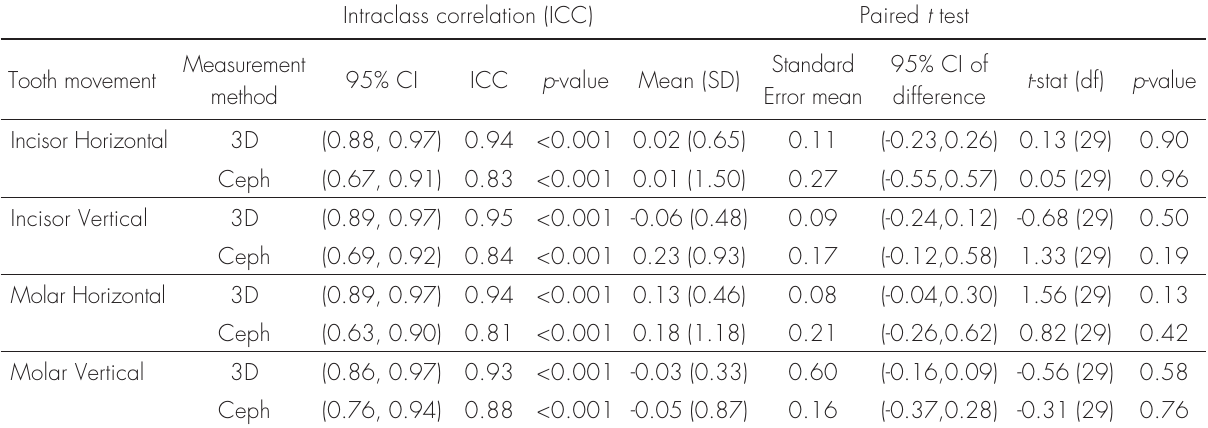
Table II. Data analysis for incisor and molar movements measured from 3D models and cephalometric radiographs, each on two separate occasions (in